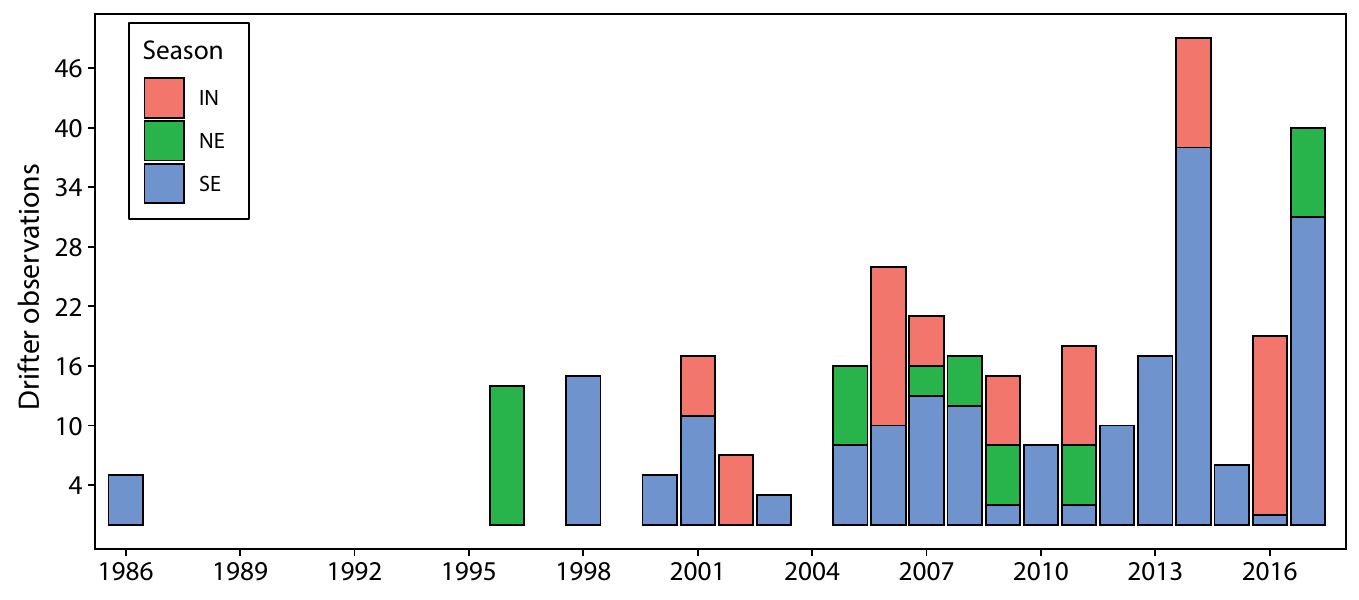
Fig 7. The annual number of drifter observations in the Pemba Channel grouped by